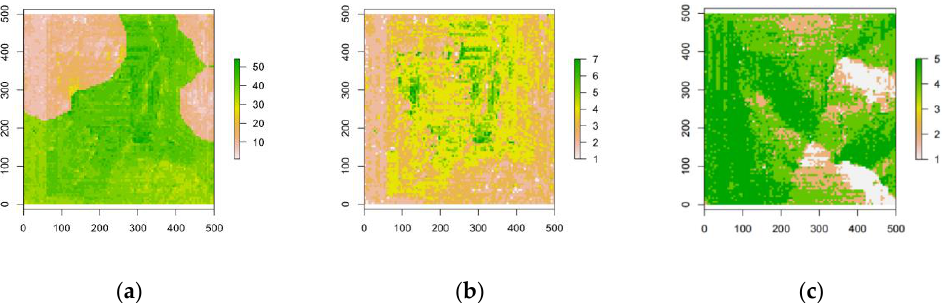
Figure 3 . ( a ) Microtopographic distribution map, color scale 1 – 54 represents microtopography type 1 – 54; ( b ) Slope classification distribution map, 1 represents the flat slope, 2 represents the gentle slope, 3 represents the slope, 4 represents the steep slope, 5 represents the sharp-steep slope, 6 rep- resents the sharp slope, 7 represents the dangerous slope; ( c ) Slope aspect classification distribution map, 1 representative the sunny slope, 2 is representative of the semi-sunny slope, 3 represents the flat land, 4 represents the semi-shade slope, 5 represents the shady slope.